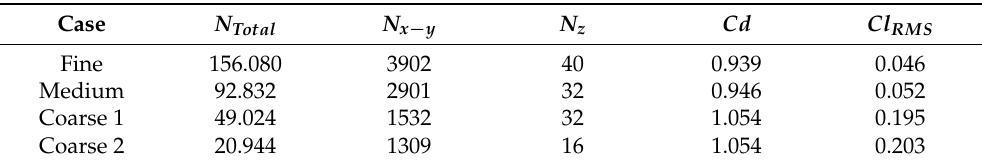
Table 3. Grid independence study: summary of tested cases with different mesh resolutions. The p-type refinement is the same in all cases, N p = 2. Relative to h-type refinement, N x − y is the number of quadrilateral elements in x – y plane, N z is the number of divisions in spanwise direction, and N Total is the total number of hexahedral